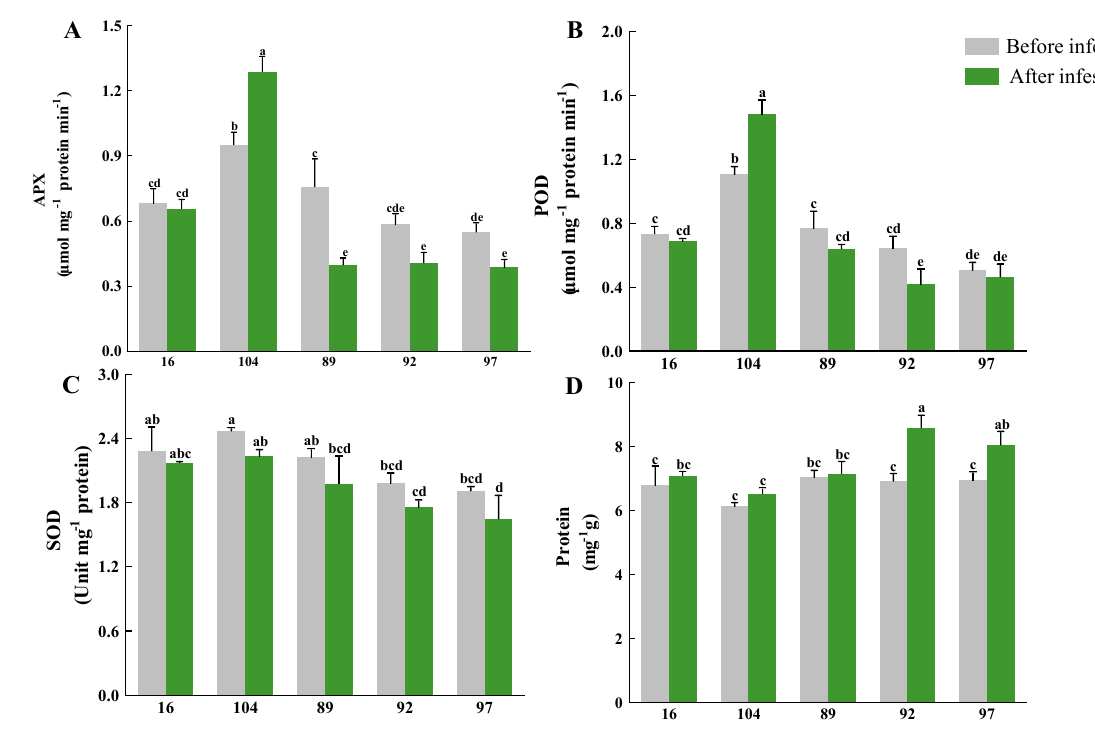
Figure 6. Effects of PPA overexpression on the activity of antioxidant enzymes and content of total proteins under infestation. Activities of ( A ) APX; ( B ) POD; ( C ) SOD and content of ( D ) proteins in leaves before and after infestation were shown; all data were presented as the mean of four replicates with standard error (SE). The letters (a−e) in the figures indicate a significant difference among experimental sugarcane lines (one−way ANOVA, p < 0.05).